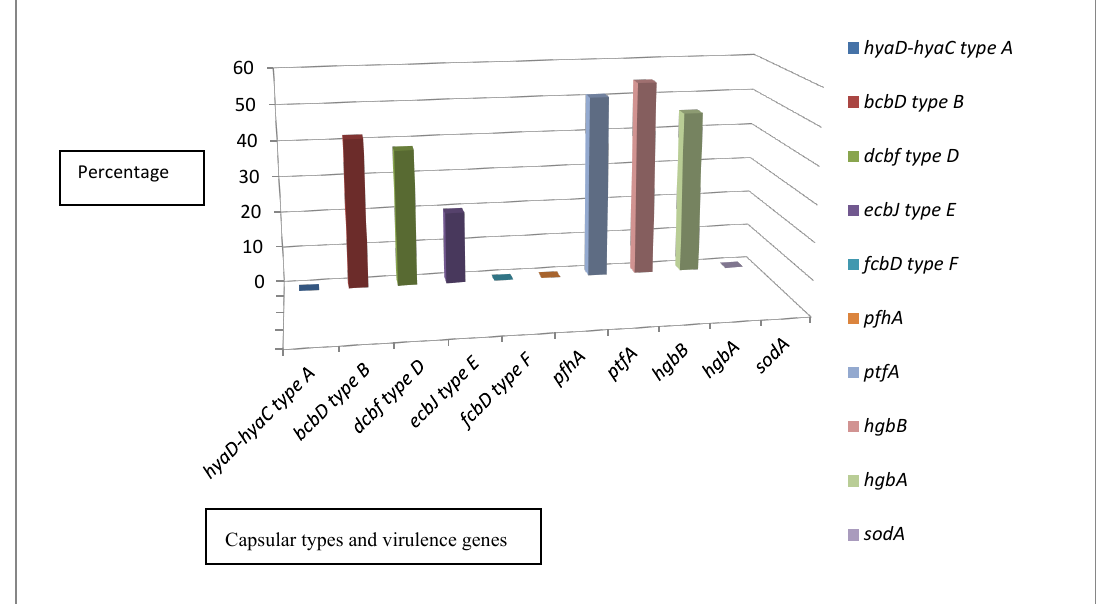
Figure 1. The results of molecular capsular typing and virulence genes.